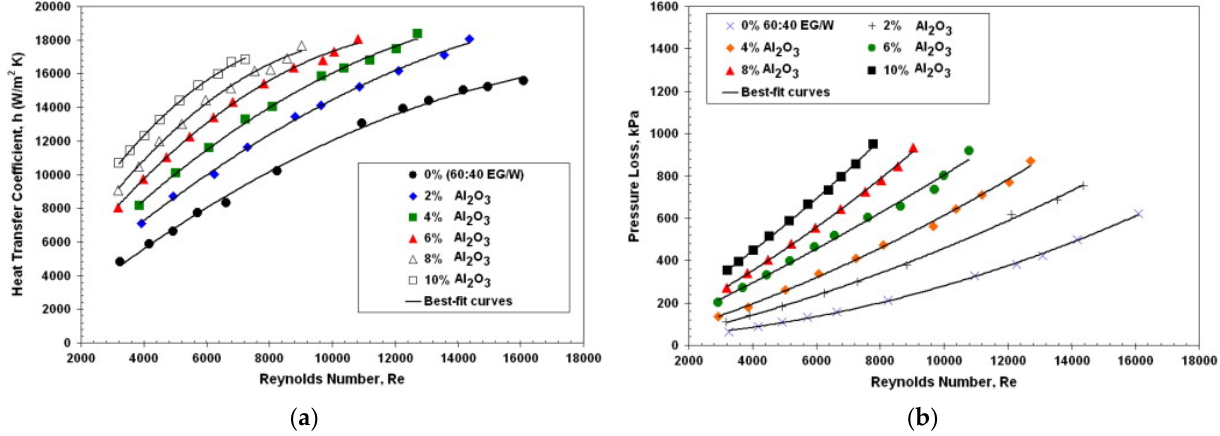
Figure 13. Variation in heat transfer rate ( a ) and pressure drop ( b ) with respect to the Reynolds number of nanofluid [39].